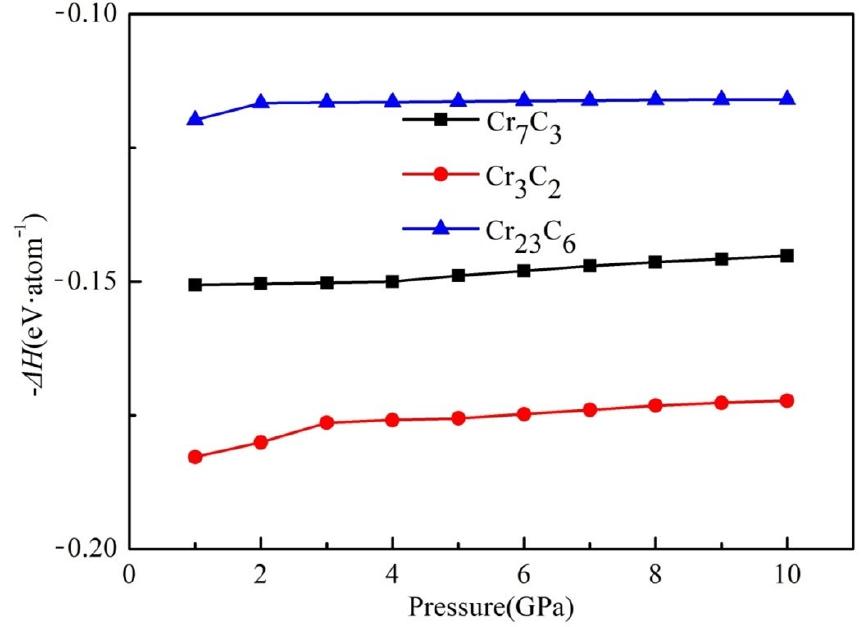
Figure 3. The formation enthalpy of binary chromium carbides under elevated pressure.